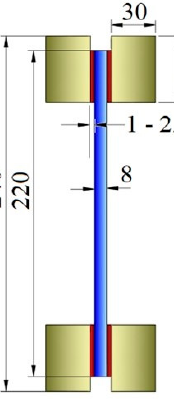
Figure 6. Cross—section of the beam specimens TGIB-gf.